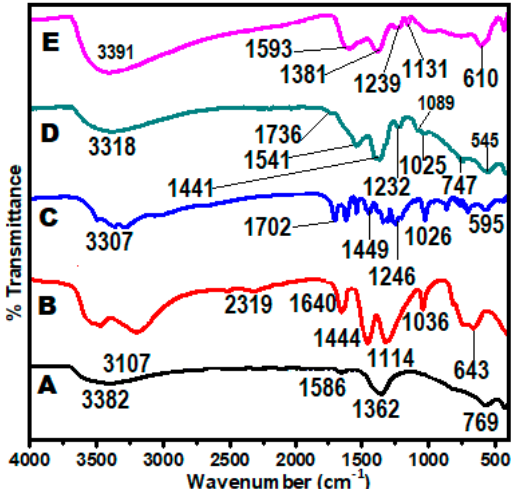
Figure 5. Fourier transform infrared spectroscopy (FT-IR) spectra (A) LDH, (B) Gd(NO 3 ) 3 , (C) pure gallic acid, (D) gallic acid-Zn/Al-LDH/Gd nanoparticles (GAGZA), (E) Gallic acid-Zn/Al-LDH/Gd-Au nanoparticles (GAGZAu).